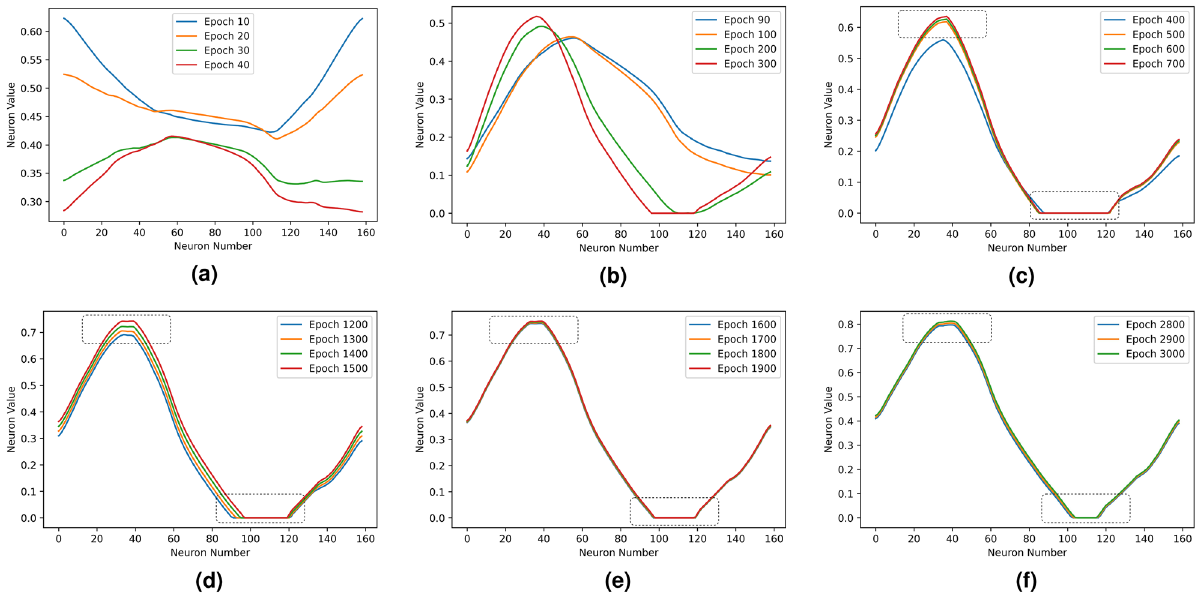
Figure 9. Fully connected layer under constrained